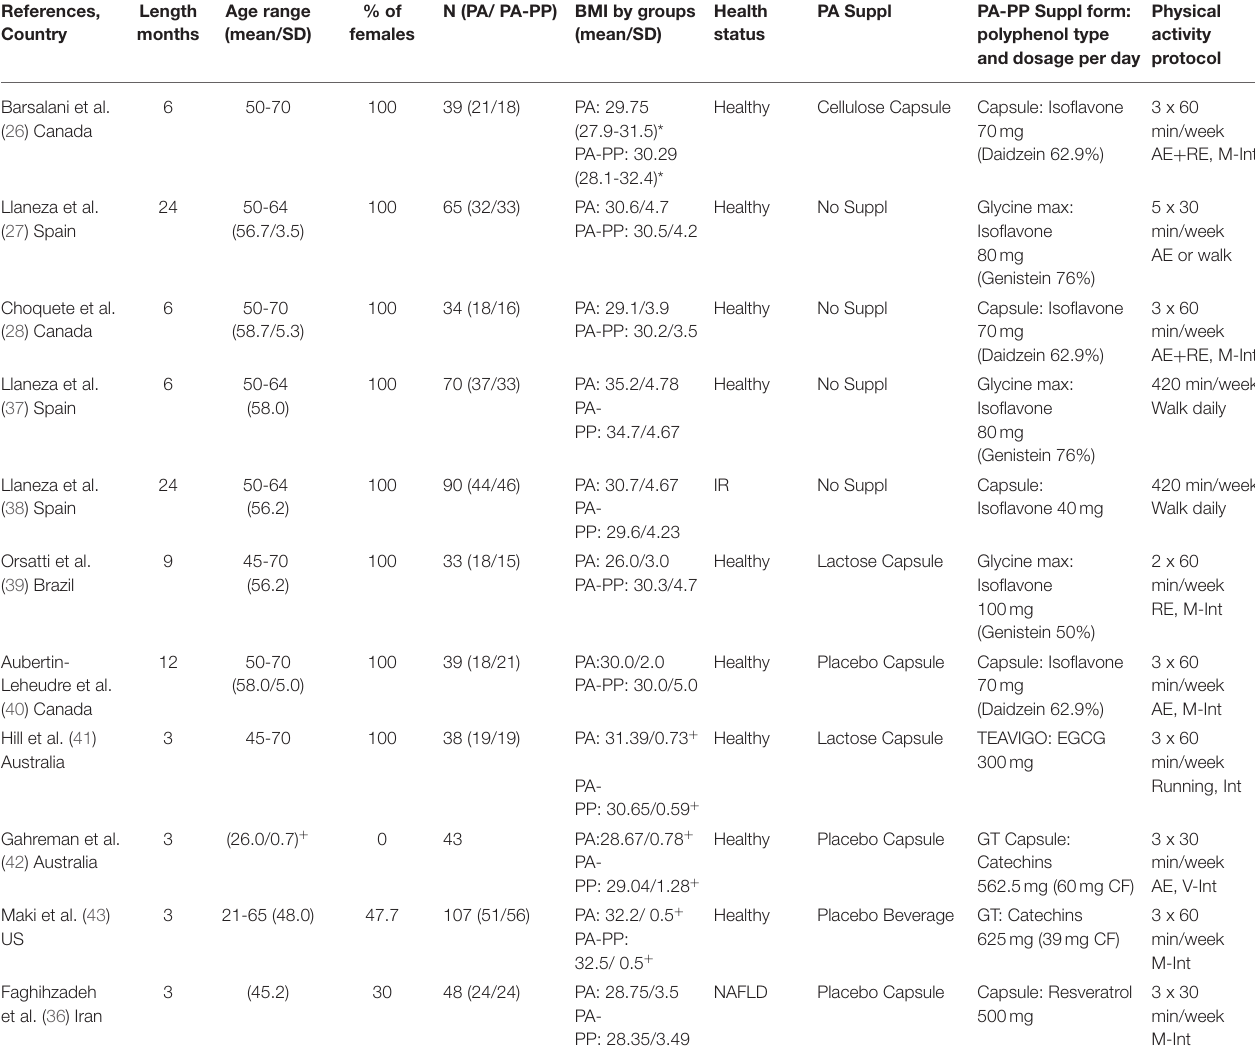
TABLE 2 | Characteristics of the studies that combined physical activity with polyphenols. References, Country